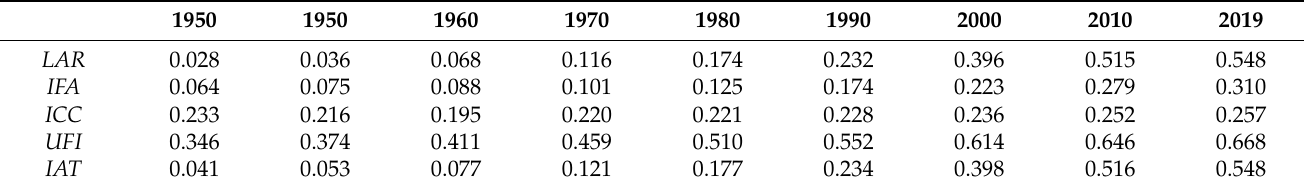
Table 3. Numerical evolution of GIS indicators of urban growth in Murcia from 1950 to 2019.